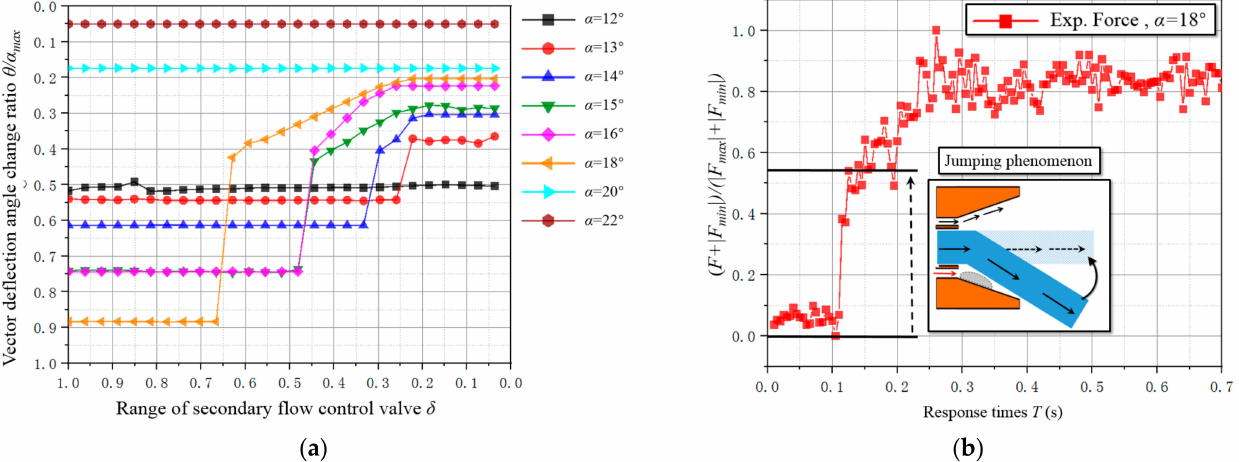
Figure 7. The jumping phenomenon of jet vector deflection in the Coanda effect nozzle. ( a ) Jet vector deflection angle θ with secondary flow valve opening δ variation curve (diffusion angle α = 12–22 ◦ ); ( b ) force variation curve of vectoring nozzle during jet dynamic detachment (diffusion angle α = 18 ◦